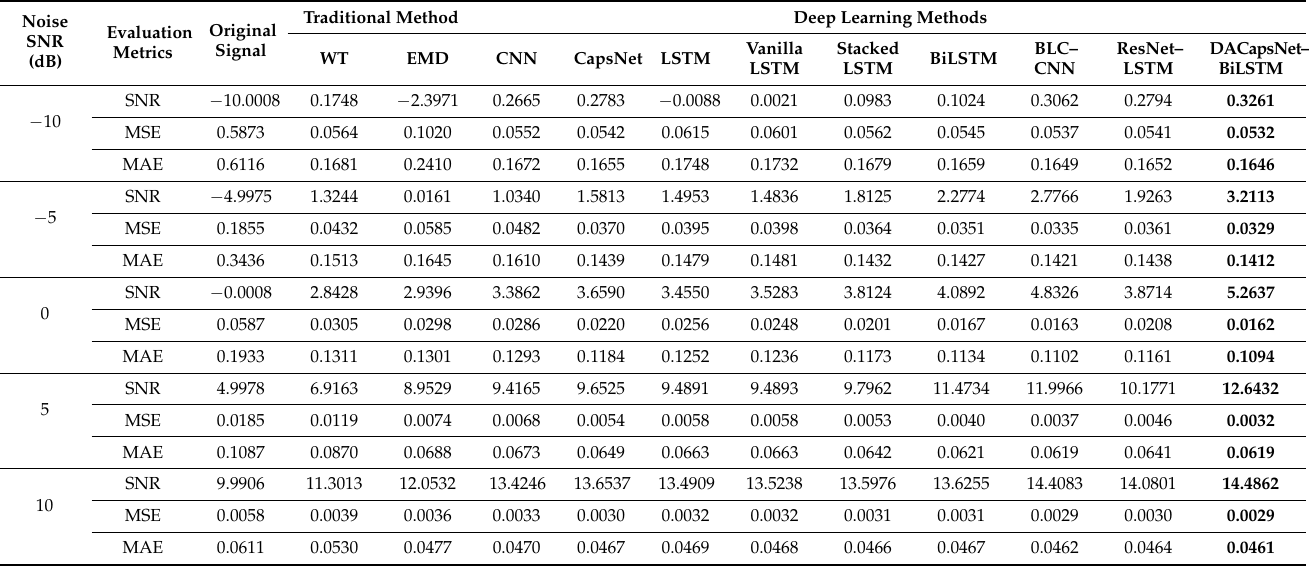
Table 3. Comparison of noise reduction performance at different noise levels.